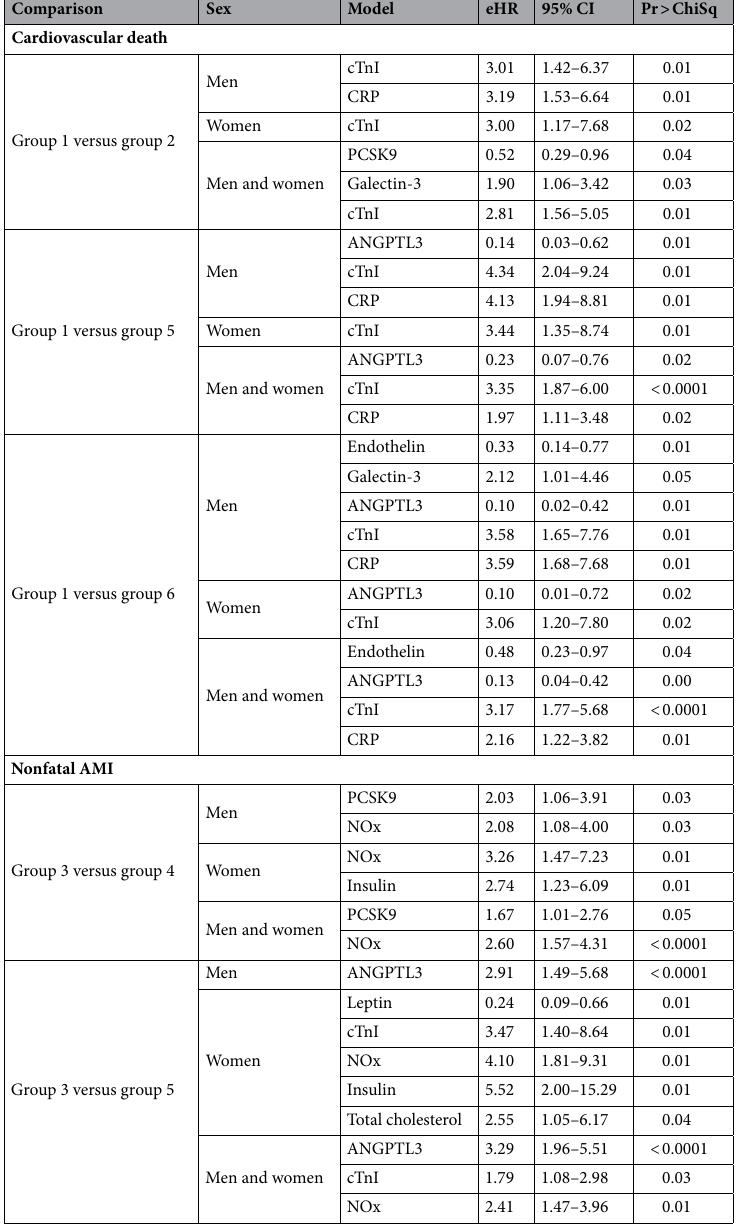
Table 2. Stepwise Cox regression analysis of associations of biomarkers with cardiovascular death and nonfatal AMI. PCSK9, proprotein convertase subtilisin/kexin type; ANGPTL3, angiopoietin-like protein